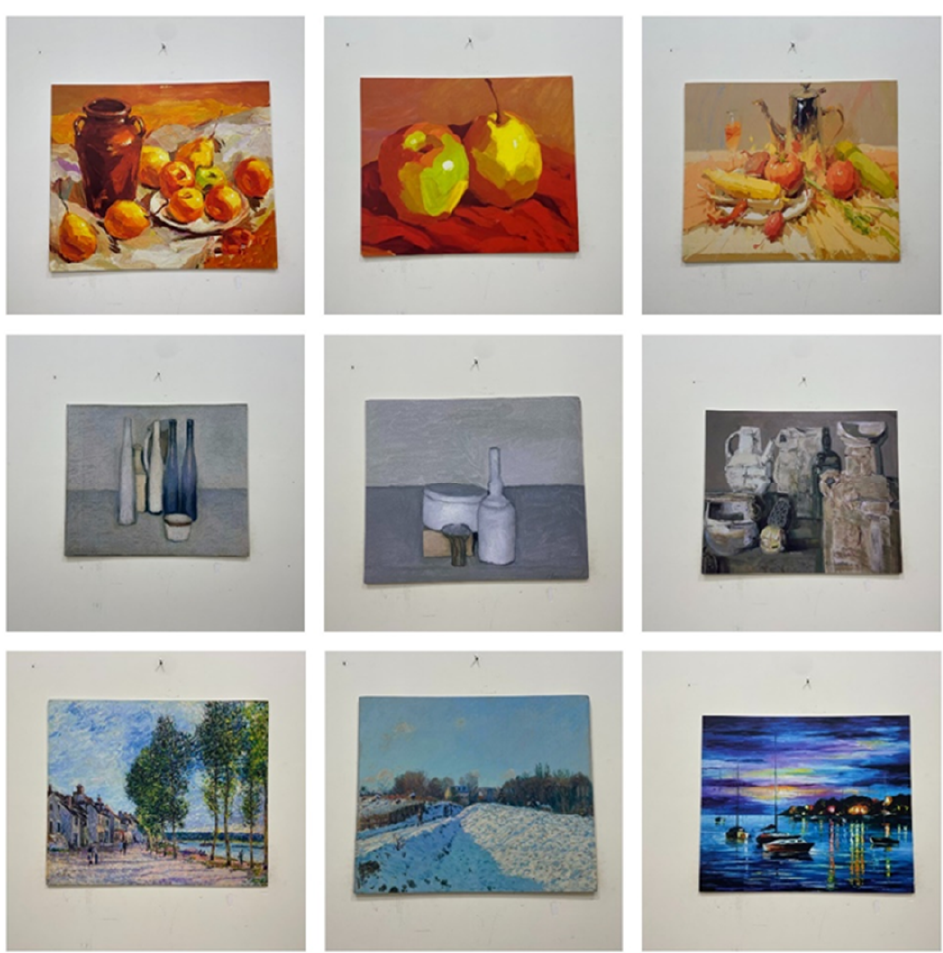
Figure 2. Three tones of paintings used in the experiment.